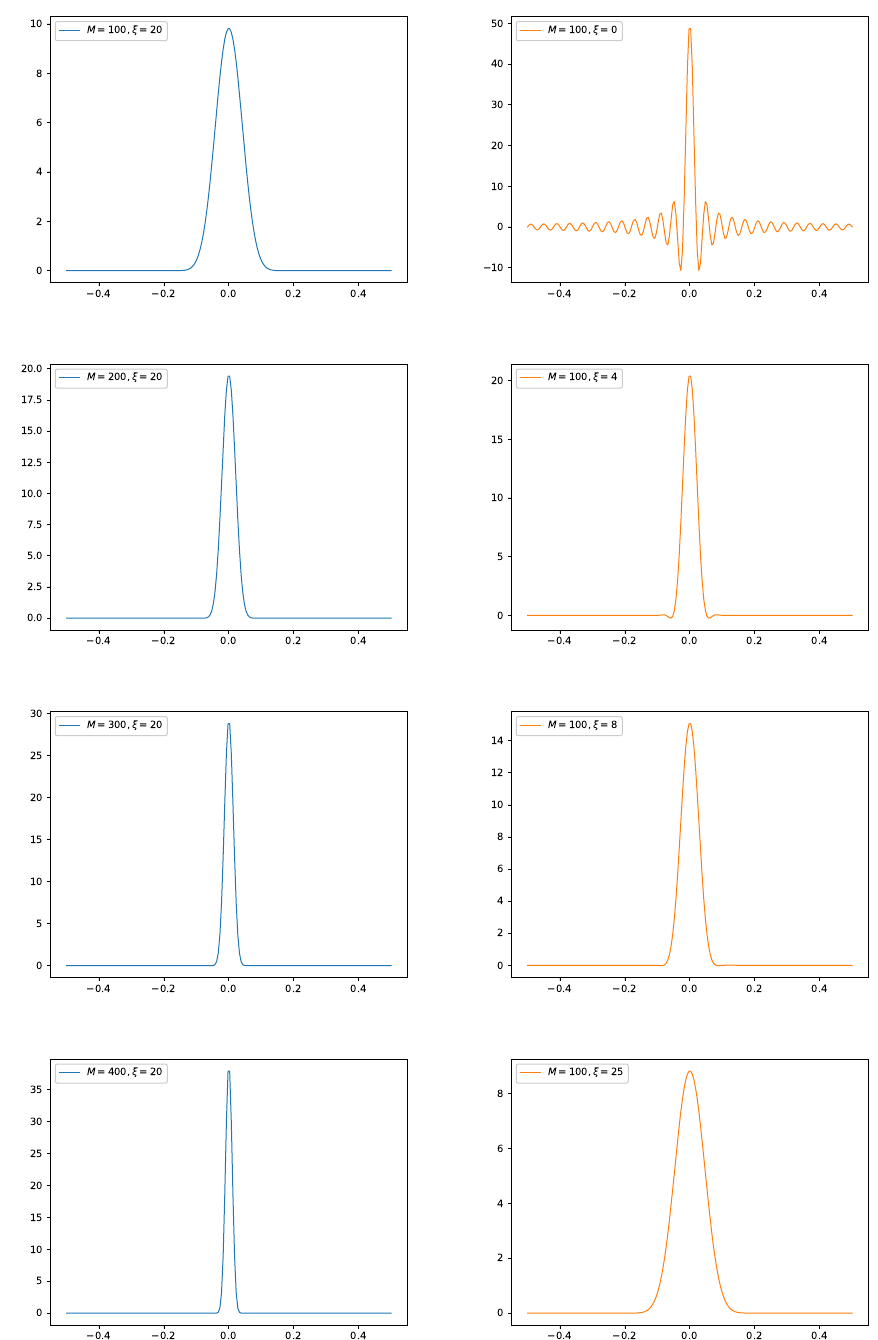
Figure 1. Effect of M and χ with center ξ = 0 on delta-shaped